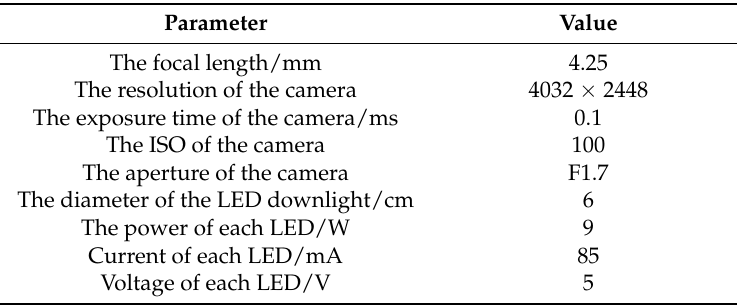
Table 1. Hardware parameters of the experiments.